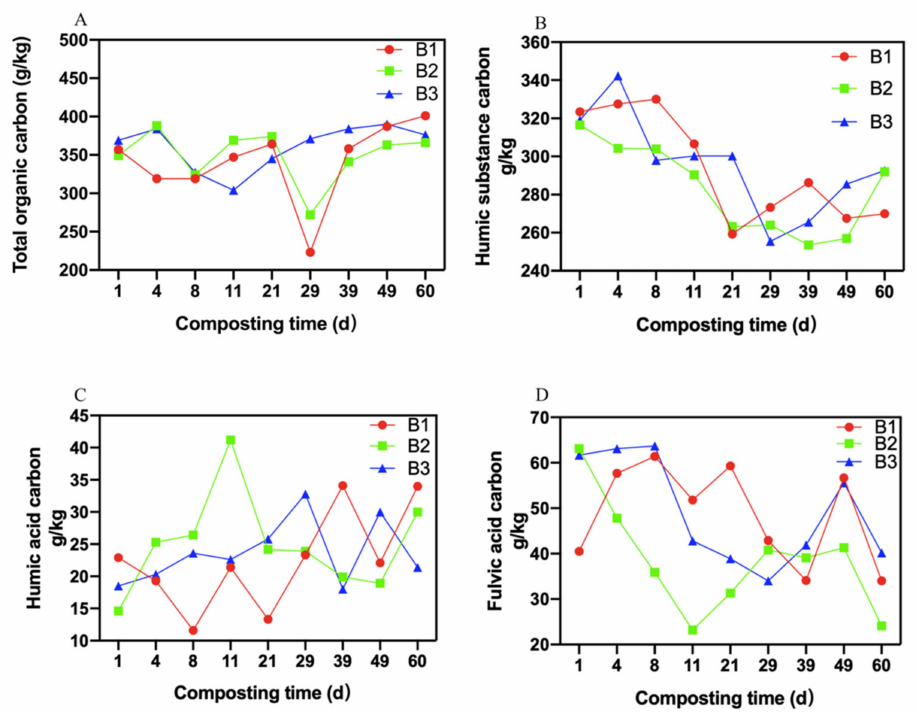
Figure 3. Variation in carbon. ( A ): Variation in TOC content; ( B ): Variation in HS-C content; ( C ): Variation in HA-C content; ( D ): Variation in FA-C